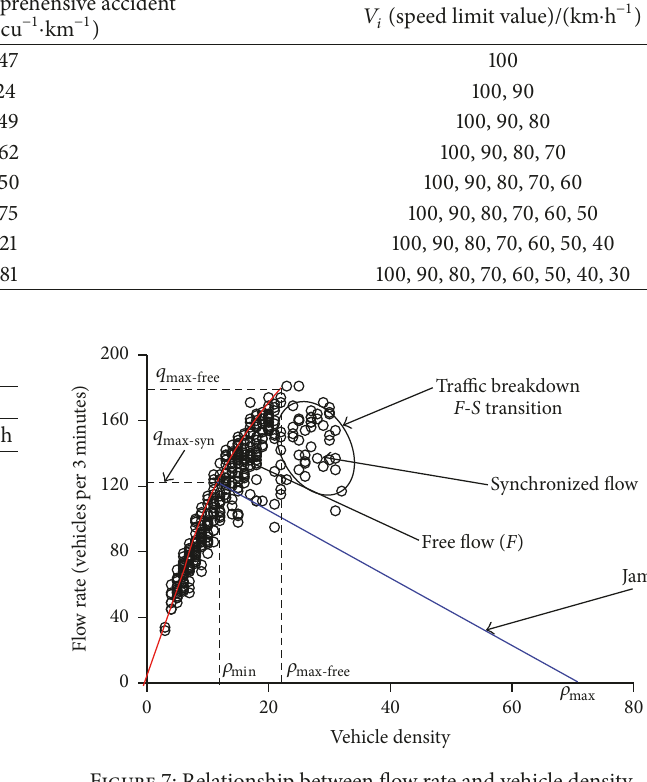
Figure 7: Relationship between flow rate and vehicle density.